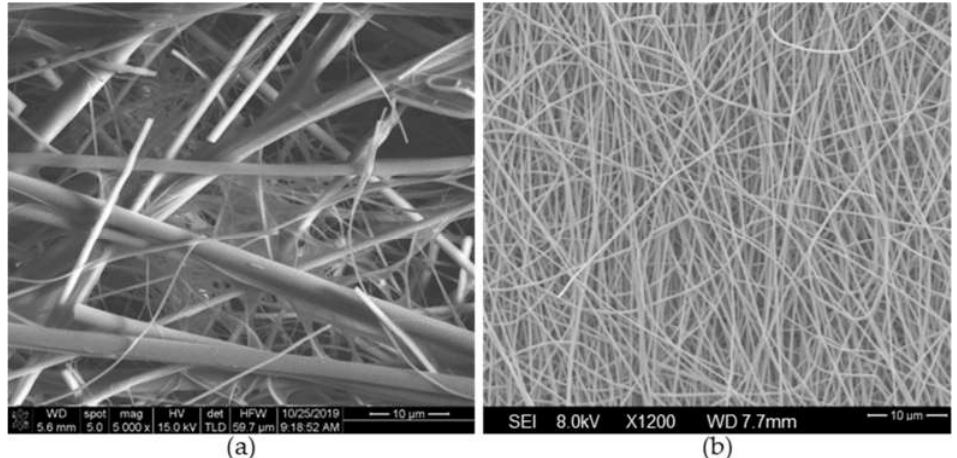
Figure 14. Comparison of electrospun polyacrylonitrile fibers with glass HEPA filter media. ( a ) Glass fiber HEPA filter media. ( b ) Stabilized electrospun fiber polyacrylonitrile filter media.